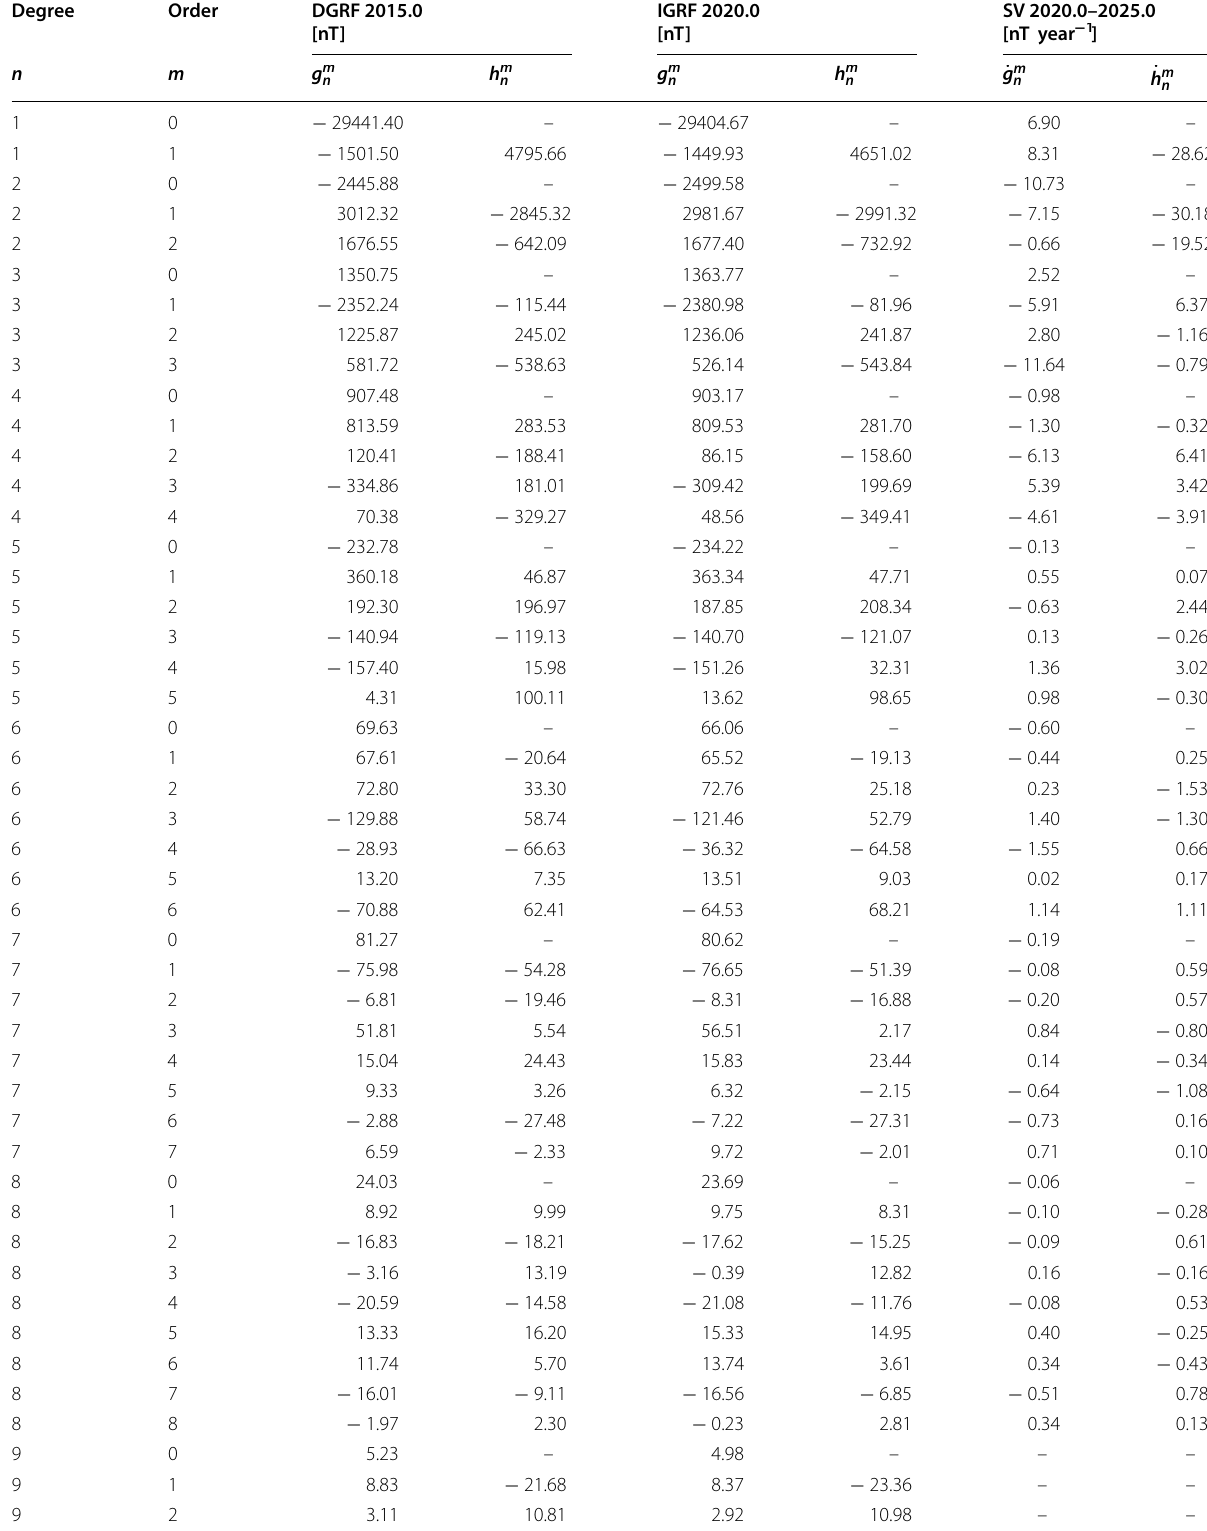
Table 4 BGS candidate model Gauss coefficient